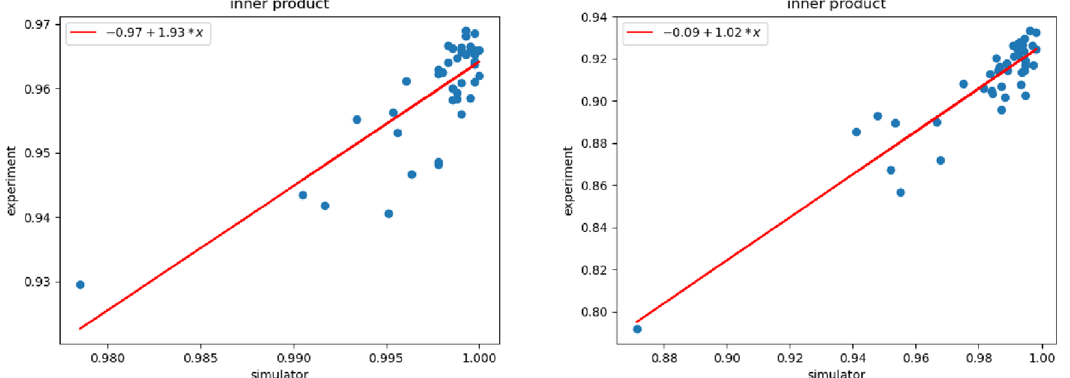
Figure 1. Scatter diagrams of simulator inner products vs. experiment inner products for both the train state vectors and test state vectors. This data corresponds to the Wisconsin Breast Cancer dataset with 8 (left) and 16 (right) features. The red lines represent optimal fit lines based on least-squared